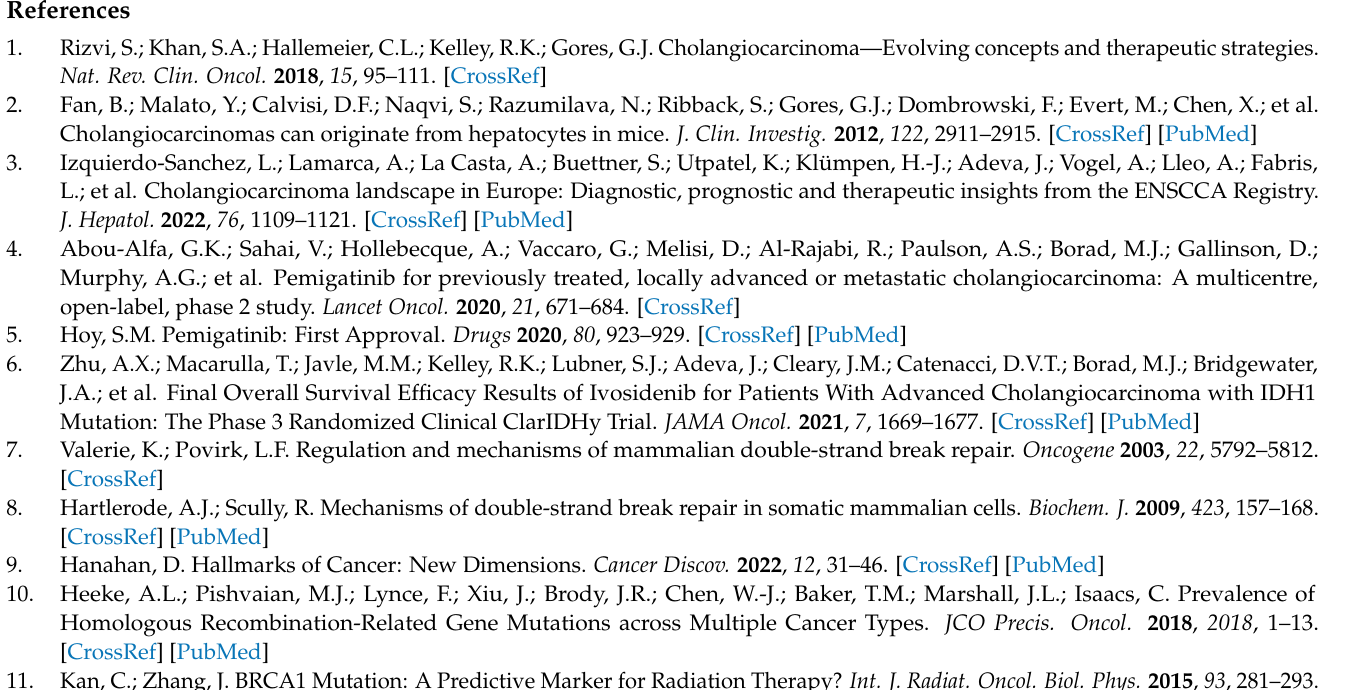
versus WT; Figure S3: Colon cancer P1 and P5–P7 WT CCA samples β -catenin immunohistochemistry; Table S1: OncoKB driver mutations cell lines overview; Table S2: OncoKB mutations (putative drivers and variants of uncertain significance) in HRR genes in cell lines overview; Table S3: Splice variants in CCA cell lines detected with Illumina TSO500 panel ® ; Table S4: CTNNB1 / APC